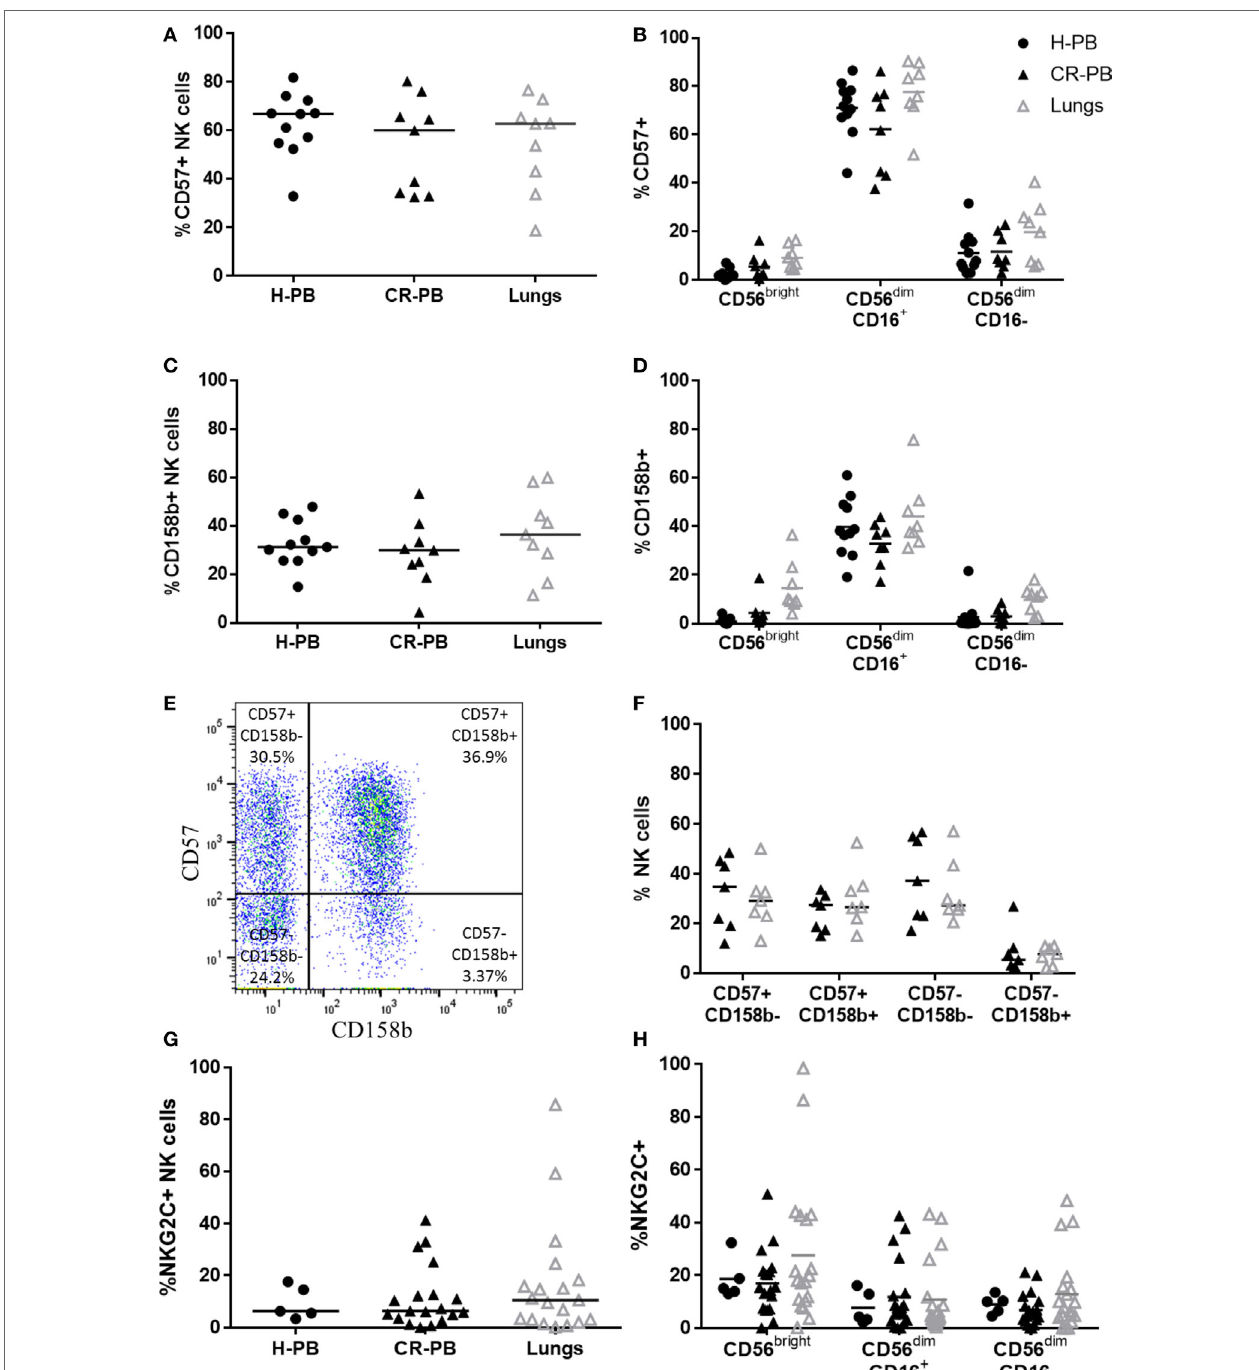
FigUre 3 | CD57, CD158b, and NKG2C expression on lung and blood natural killer (NK) cells. CD57 (a) and CD158b (c) expression on NK cell subsets in peripheral blood of healthy controls [healthy peripheral blood (H-PB) N = 11] and peripheral blood [peripheral blood from cancer resection donor (CR-PB)] and lung of cancer resection patients ( N = 9). Lines describe medians, comparison between healthy and resection blood by Mann–Whitney U test and between lung and CR-PB by Wilcoxon signed-rank test. (B,D) CD57 and CD158b expression on CD56 bright , CD56 dim CD16 + , and CD56 dim CD16 − NK cells from the blood and lung. Statistical analysis of H-PB to CR-PB by Kruskal–Wallis test with Dunn’s multiple comparison correction and CR-PB to lung tissue by Friedman’s test with Dunn’s multiple comparison correction. (e) Representative flow cytometry plot describing lung NK cell CD57 and CD158b expression. (F) CD57 and CD158b expression on NK cells from the lung and matched blood [CR-PB ( N = 7)]. Statistical analysis by Friedman’s test with Dunn’s multiple comparison correction. (g) NKG2C expression on healthy controls ( N = 5), cancer resection donor blood and lung tissue ( N = 19). (h) NKG2C expression on CD56 bright , CD56 dim CD16 + , and CD56 dim CD16 − NK cells from the blood and